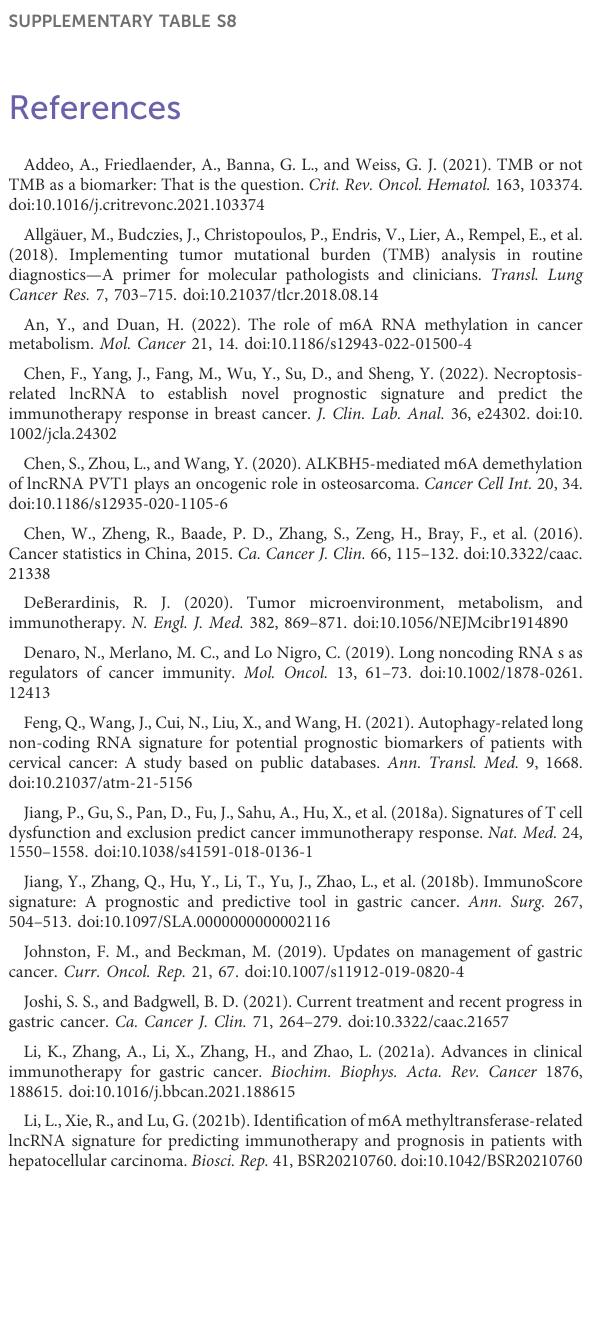
SUPPLEMENTARY TABLE S6 The details of univariate and multivariate Cox analyses. SUPPLEMENTARY TABLE S7 The details of GO enrichment analysis.